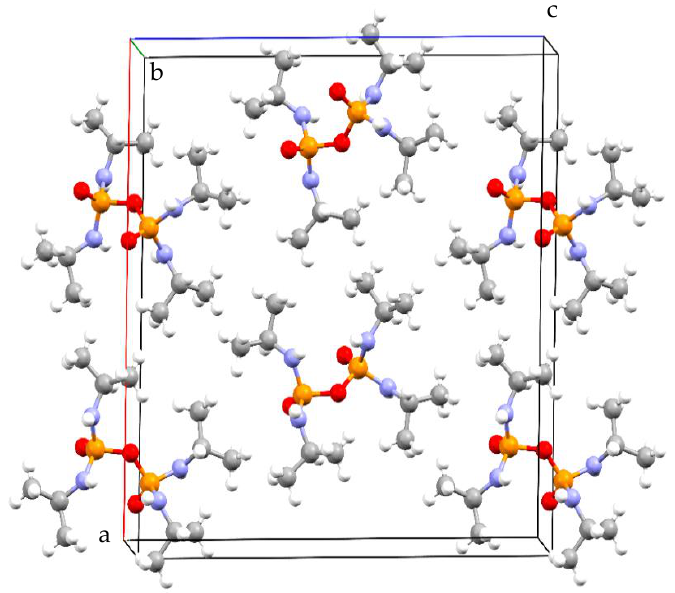
Figure 2. Unit cell for O(( i PrNH) 2 PO) 2 viewed along the b-axis (generated in Mercury [25]). Table 1. Crystal data and structure refinement for O( i PrNH) 2 PO) 2 .